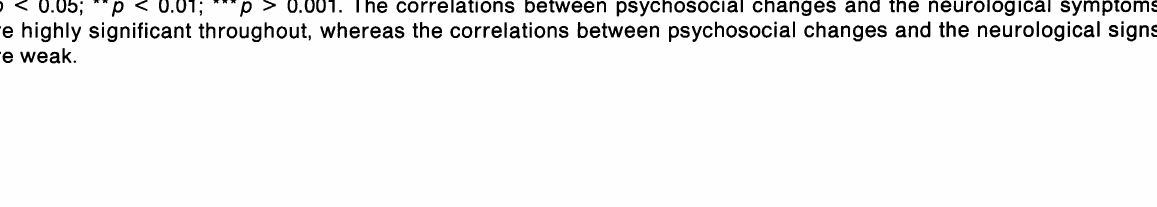
TABLE II. Correlations between coping (FKV), demographic variables, signs (neurological assessment) and symptoms